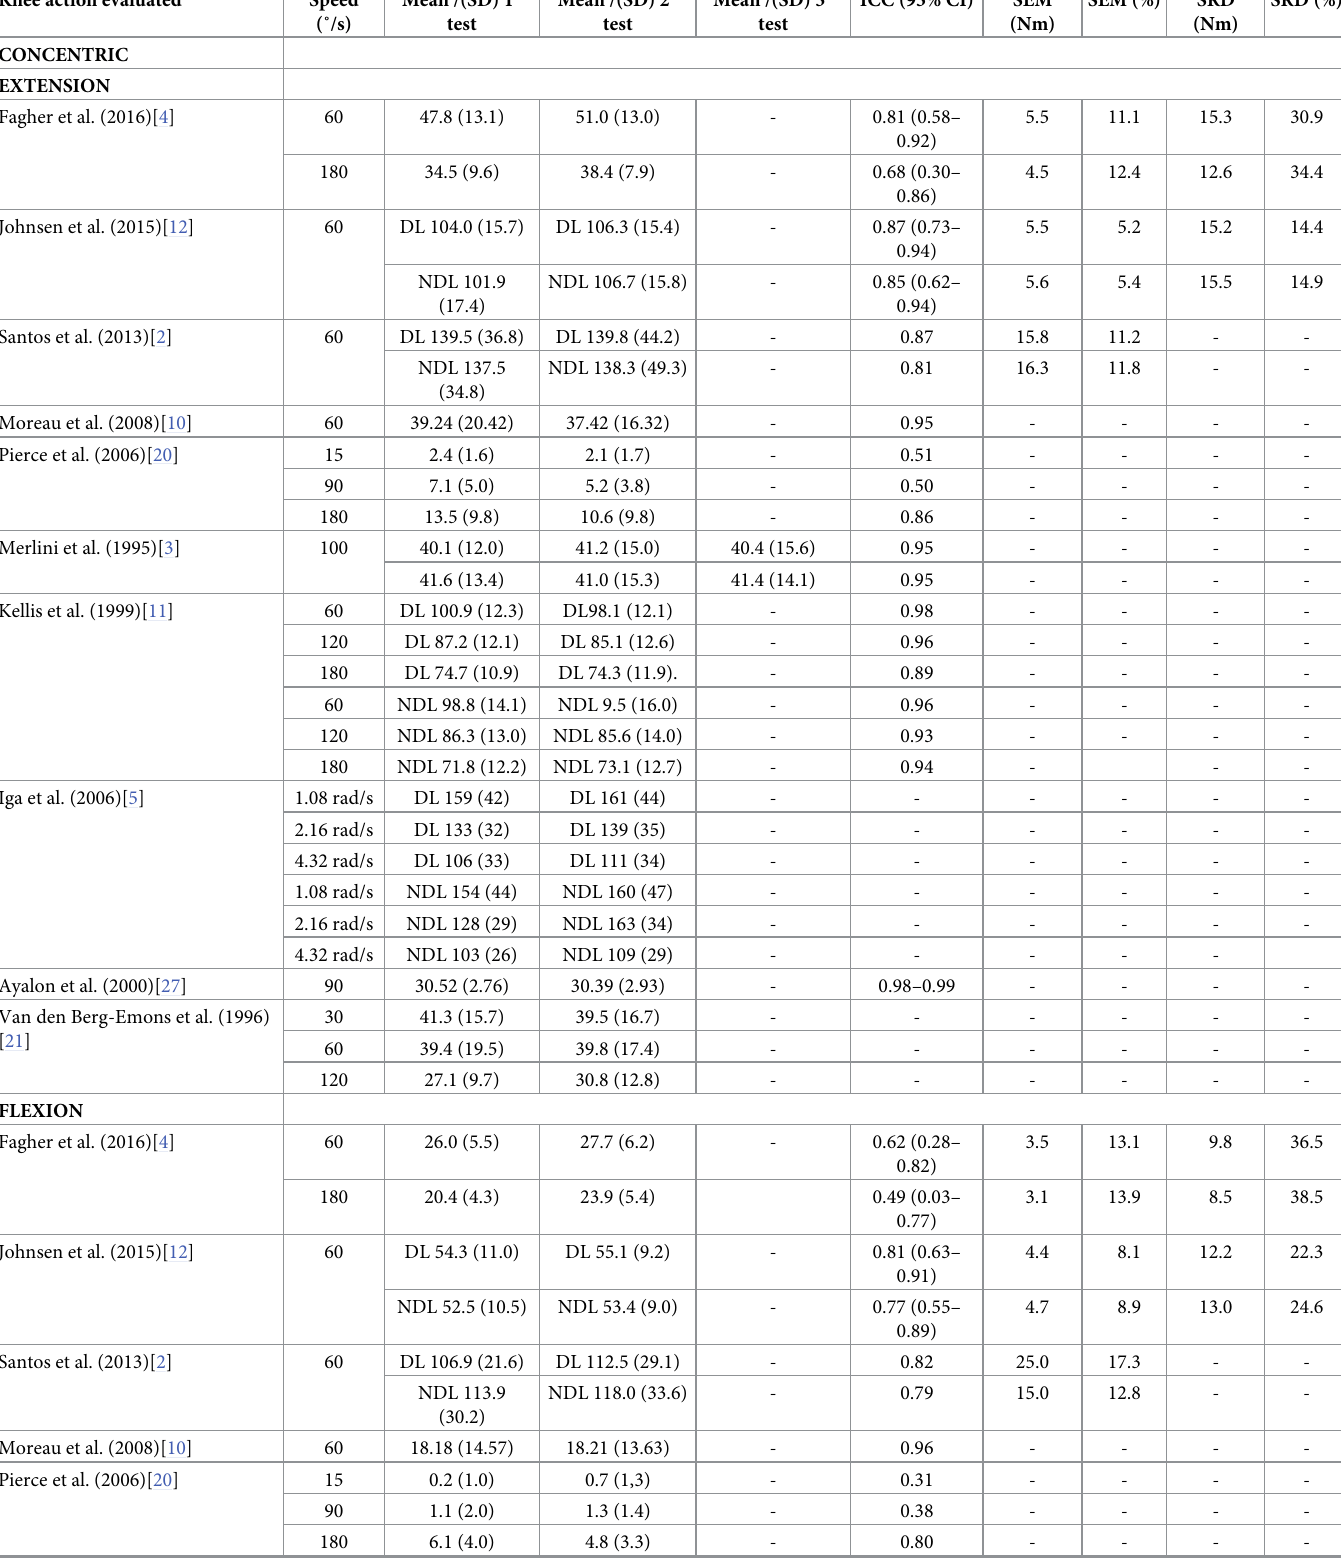
Table 4. Relative and absolute reliability of concentric extension and flexion of the knee in